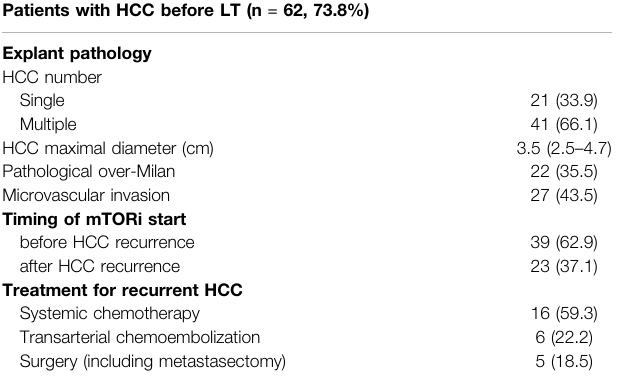
TABLE 3 | Demographics of the patients who had HCC before LT. Patients with HCC before LT (n = 62,